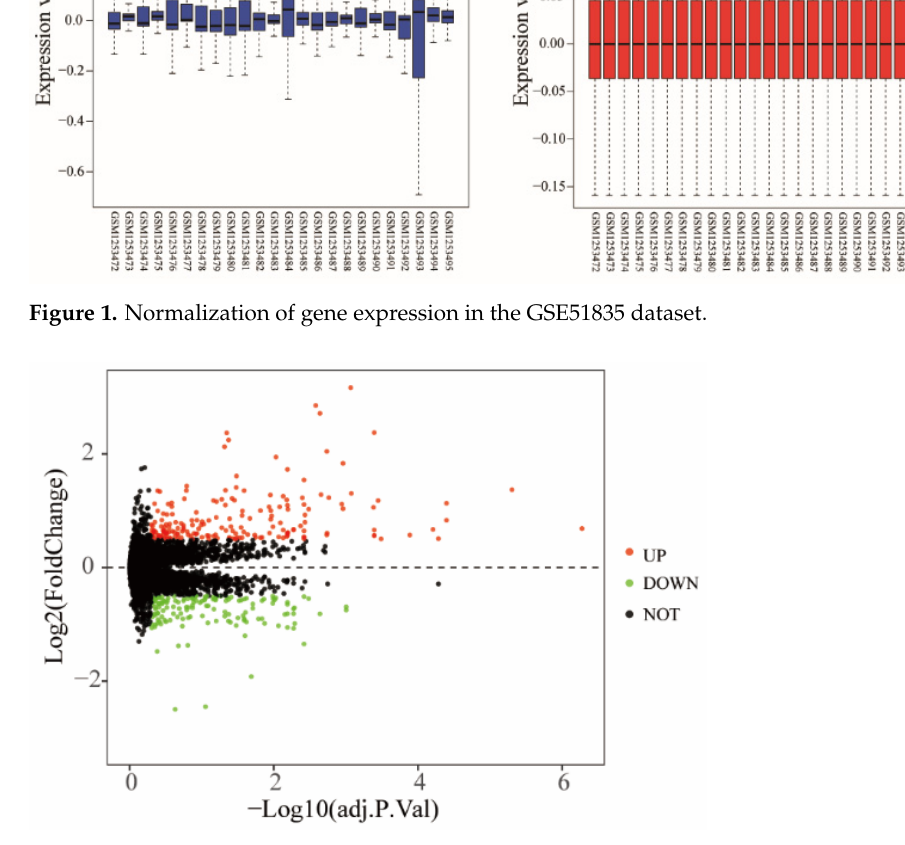
Figure 3. Hierarchical clustering heat map of the top 50 DEGs. Red indicates that gene expression is relatively upregulated, green indicates that gene expression is relatively downregulated, and black indicates no significant changes in gene expression. 3.2. Enrichment Analyses of DEGs The DAVID database was used to perform GO functional annotation analyses of the previously identified DEGs. The top 5 GO terms in each group are shown in Table 1. Re- sults of GO functional annotation analysis included three groups: biological process (BP), cellular composition (CC), and molecular function (MF). In the BP group, DEGs were mainly enriched in cellular response to hydrogen peroxide, response to unfolded protein, negative regulation of cell proliferation, cellular response to laminar fluid shear stress, and positive regulation of protein metabolic process. For cellular composition, DEGs were mostly enriched in nucleus, membrane-bounded organelle, intracellular membrane- bounded organelle, cytoplasm, and nucleoplasm. MF analysis showed that DEGs were